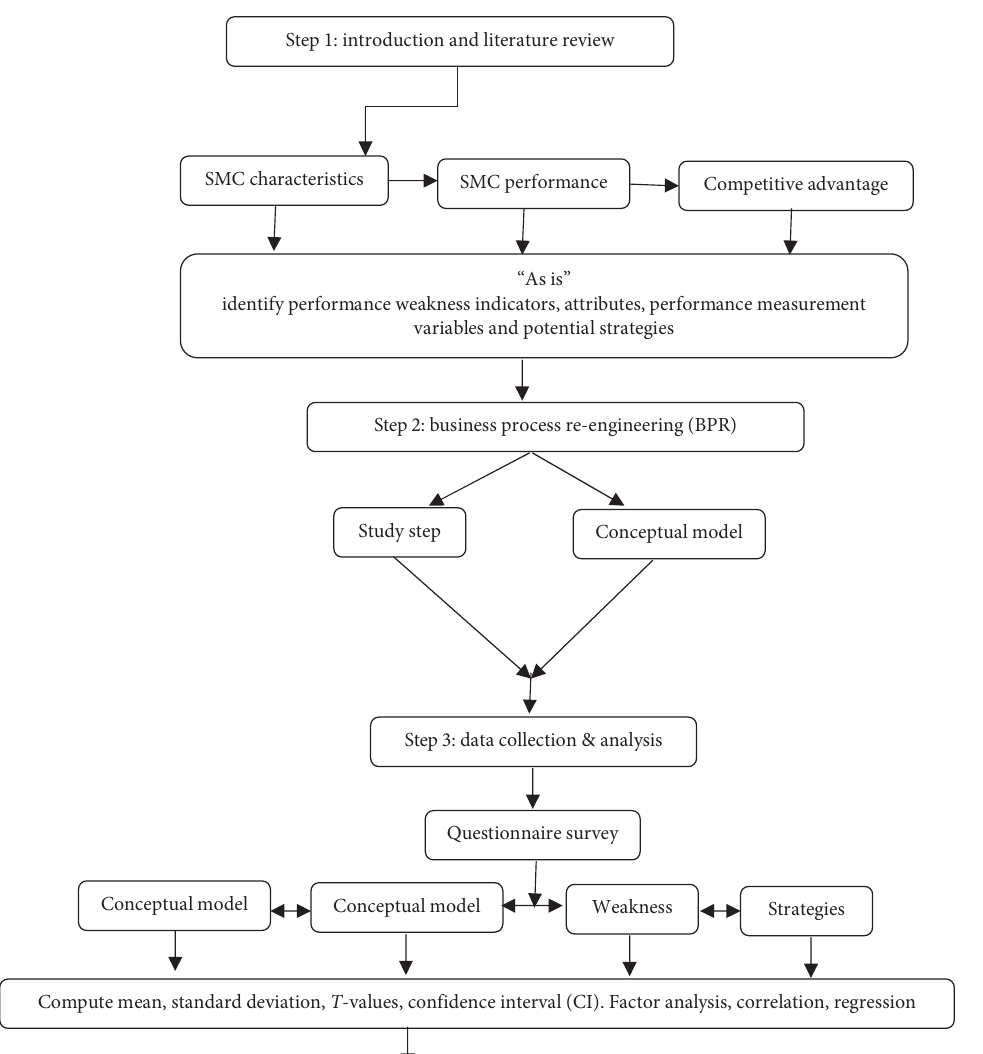
Figure 1: A framework to prioritize